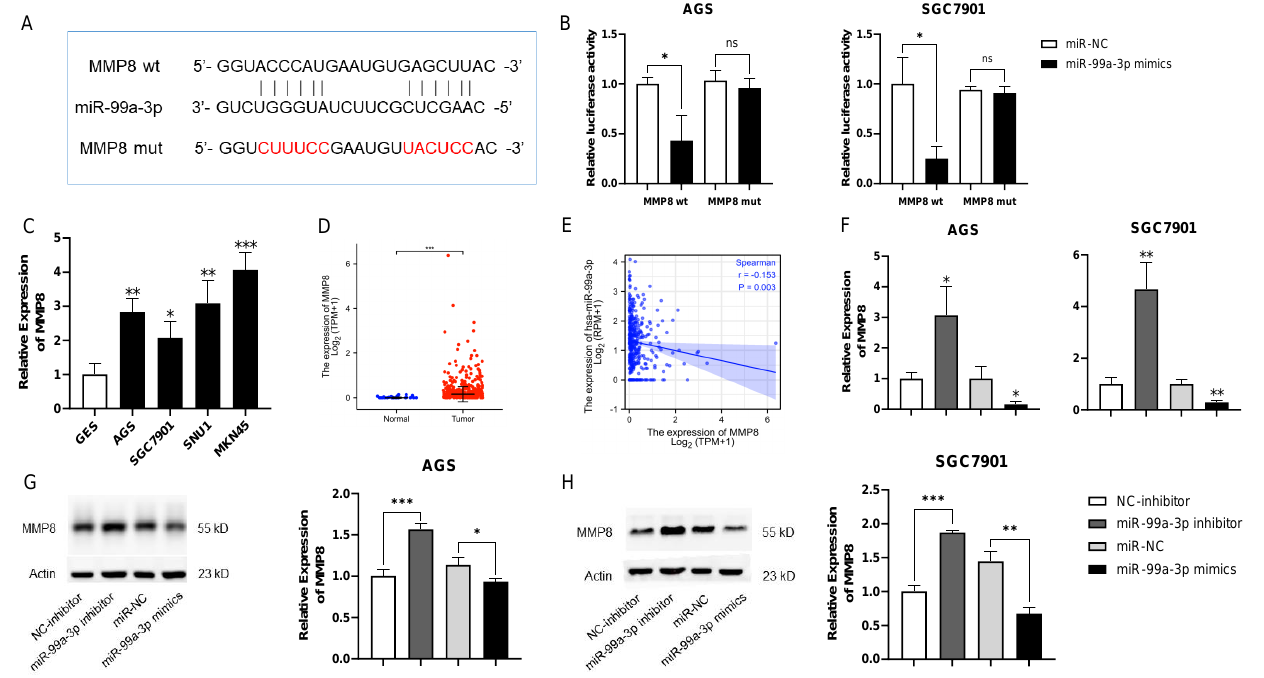
Figure 4. MiR-99a-3p regulated MMP8 in GC. ( A ) The forecast binding site between miR-99a-3p and MMP8 using TargetScan. ( B ) Interaction between miR-99a-3p and MMP8 explored by the dual- luciferase reporter gene assay in AGS and SGC7901 cell lines. ( C ) MMP8 expression in GES, AGS, SGC7901, SNU1 and MKN45 by qRT-PCR. ( D ) MMP8 expression in normal and tumorous gastric tissues from TCGA. ( E ) The relevance of miR-99a-3p and MMP8 expression. ( F ) MMP8 expression after overexpression and downregulation of miR-99a-3p by qRT-PCR. ( G , H ) MMP8 expression under overexpression and downregulation of miR-99a-3p in AGS and SGC7901 cell lines by western blot. Full blotting could be found at Figures S1–S3. ns represents no significance. * p < 0.05; ** p < 0.01; *** p <